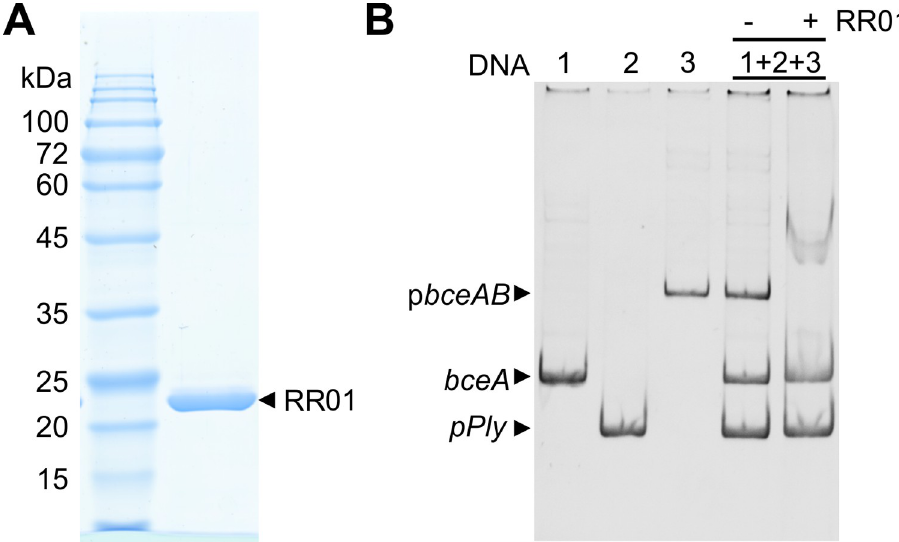
DNA fragments covering the promoter region of BceAB genes (p bceAB , 557 pb), the promoter region of the pneumolysin ply gene (p Ply , 250-bp) and an internal region of the bceA gene ( bceA , 379-bp) were incubated with an excess of the purified RR01 (D52E) mutant. A representative experiment of three independent ones is shown